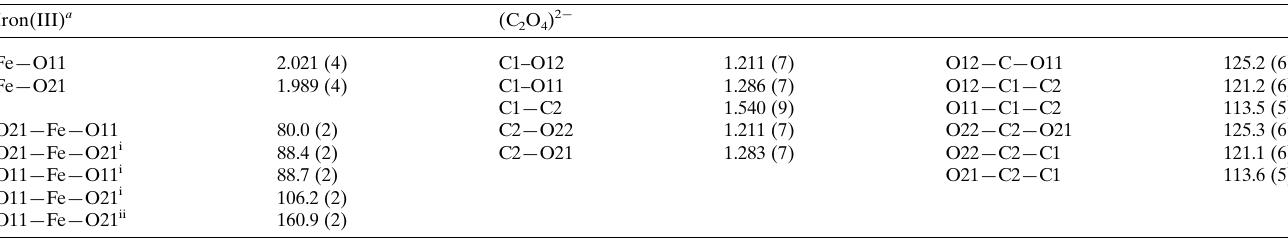
Table 1 Bond lengths and angles (A˚ , (cid:5) ) around iron(III) and within the oxalate dianion in NaRb 5 [Fe(C 2 O 4 ) 3 ] 2 P 4 3 32 enantiomer. ( a ) At a crystal site of C 3 point group symmetry. Iron(III) a Fe—O11